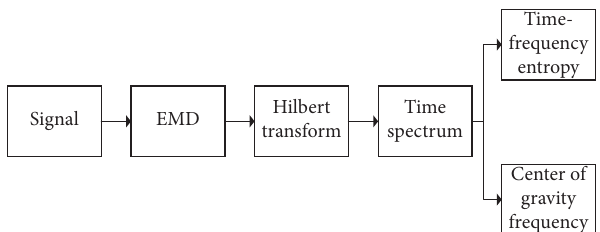
Figure 8: Overall block diagram of frequency-domain feature extraction for fiber vibration